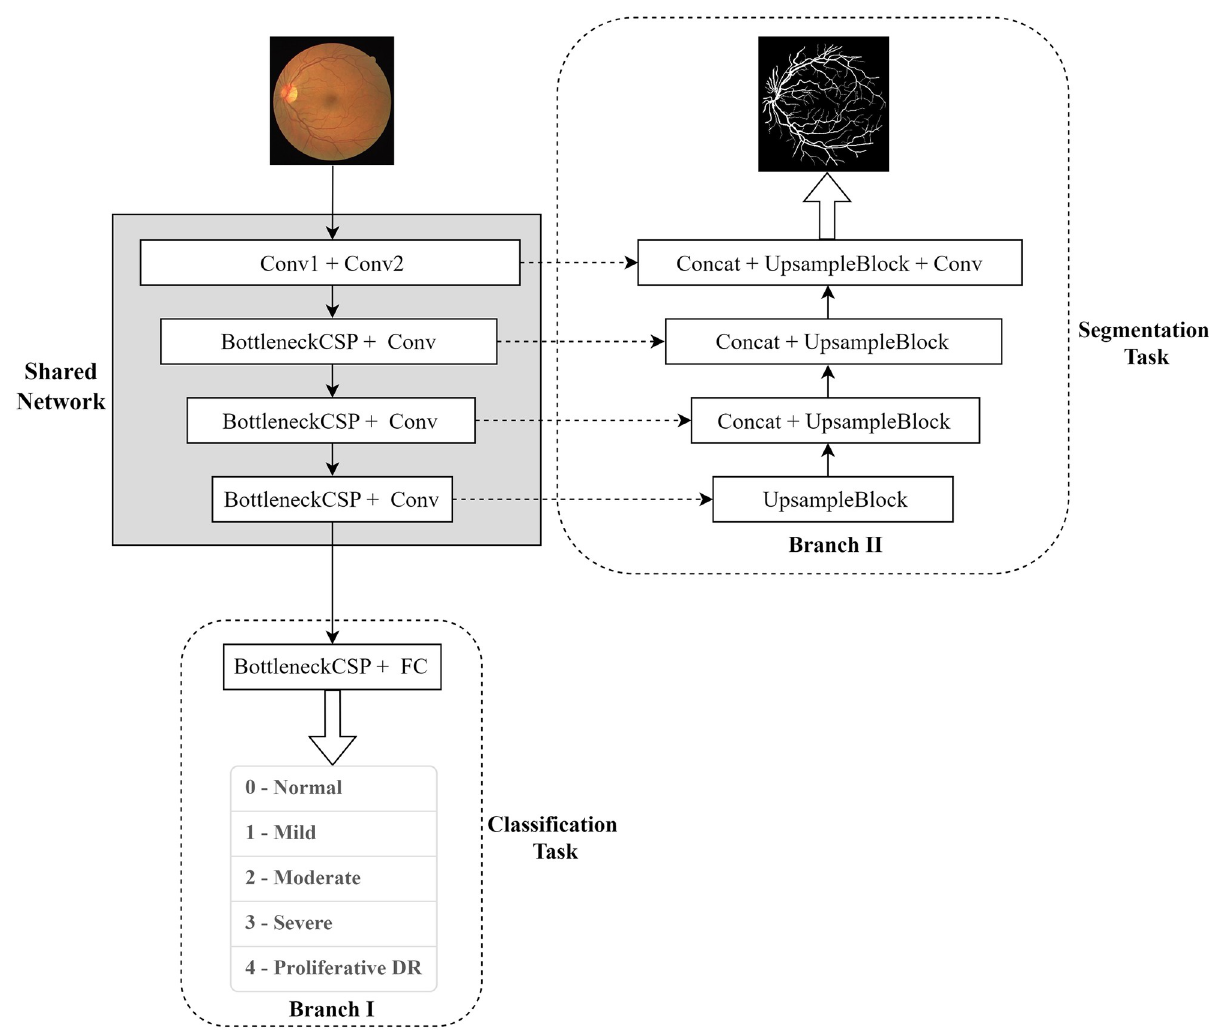
Fig 5. Structure diagram of UpsampleBlock